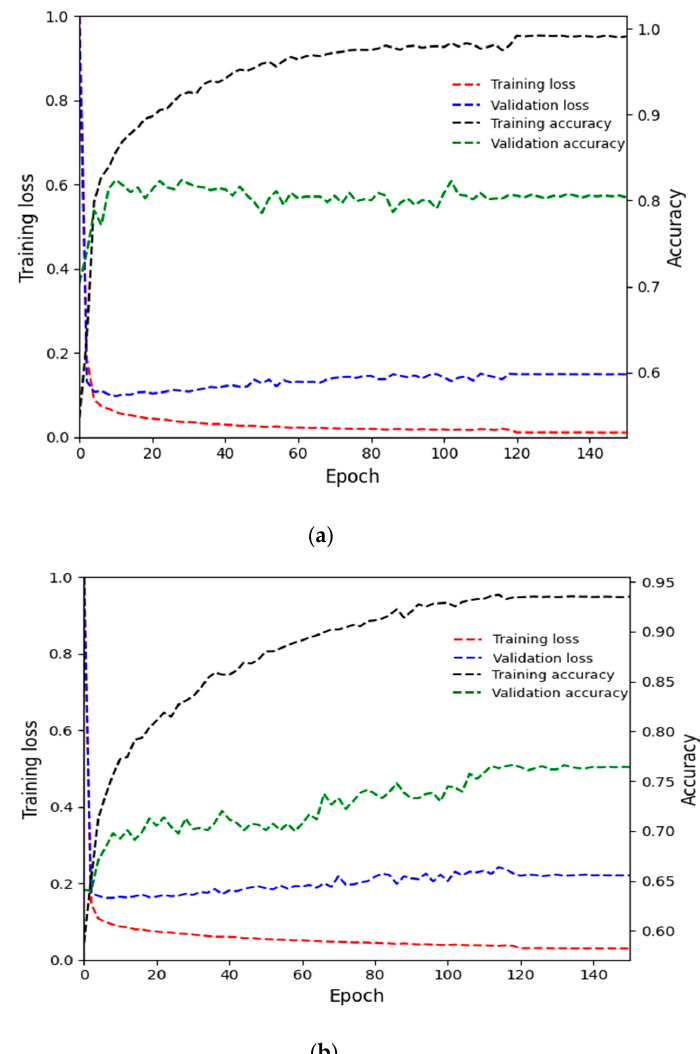
Figure 6. Training and validation loss and accuracy graphs of MBDM: ( a ) is the loss and accuracy for the training and validation data in the first fold, and ( b ) is the loss and accuracy for the training and validation data in the second fold.